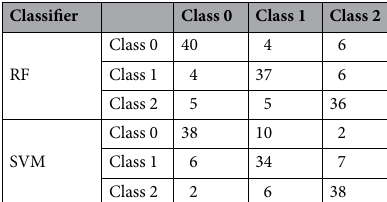
Table 5. Classification results for each two-groups comparison with the two tested classifiers, using only the LF Power (%) and MSE17 features.